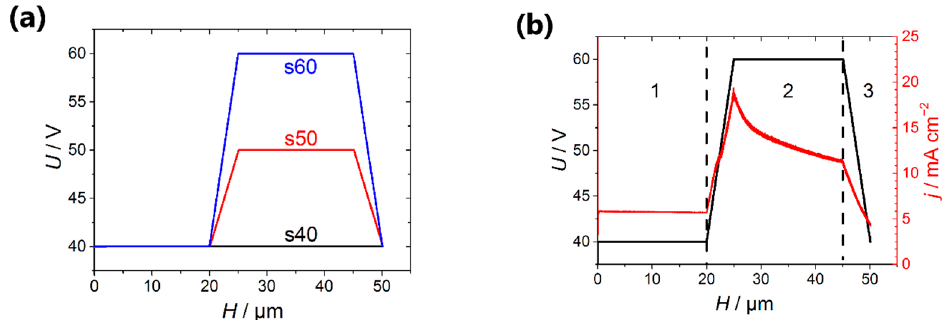
Figure 2. ( a ) The programs of aluminum anodization in 0.3 V oxalic acid at the temperature of 20 ◦ C, which was used for the obtaining of porous films with partially blocked channels; ( b ) the dependences of the applied voltage (black line) and registered current density (red line) on the thickness of the porous film recorded at the second anodization stage in the case of the use of the template s60. The regions 1, 2 and 3 correspond to the following processes: 1) The formation of the upper part of the template designed for the electrodeposition of metal; 2) the blocking of a certain pores fraction; 3) the thinning of the barrier layer. The thickness of the porous film formed during the first anodization was 10 µm.